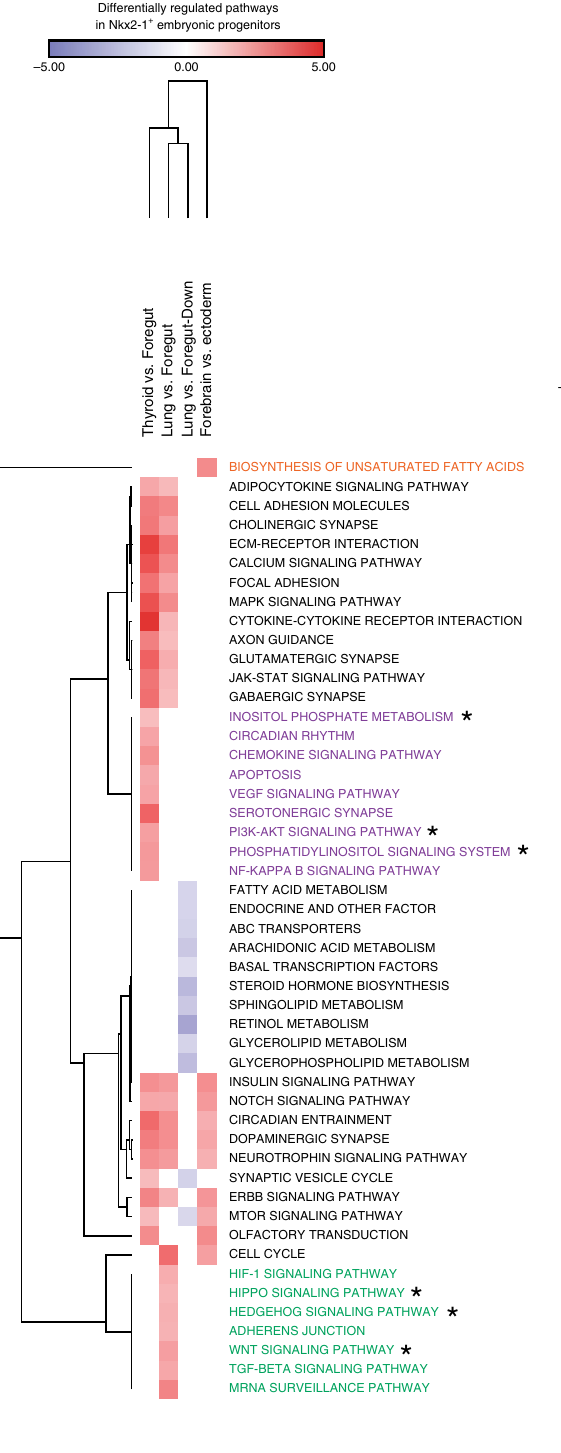
Entrainment ” ), or in two out of three populations (e.g., “ Cytokine – Cytokine Receptor Interaction ” in the lung pri- mordium and thyroid). On the other hand, certain signaling pathways were progenitor-speci fi c (seven for the lung, ten for thyroid, and one for forebrain, Supplementary Fig. 3B). Wnt, Hedgehog, Tgf- β superfamily, and Hippo pathways were upre- gulated exclusively in lung primordial progenitors